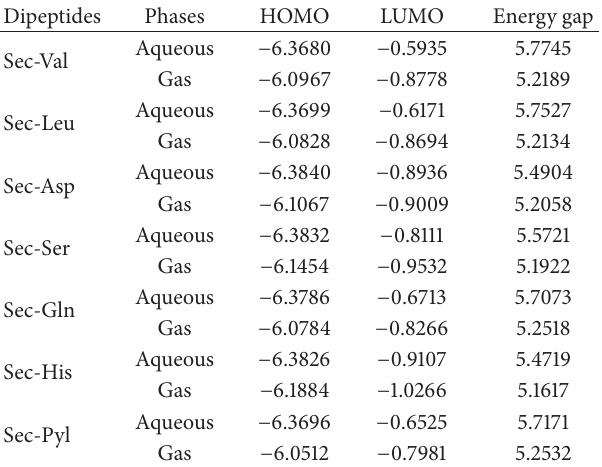
Table 8: HOMO and LUMO energies (eV) and their energy gaps for the dipeptides at B3LYP/6-311++G(d,p) level in gas and aqueous